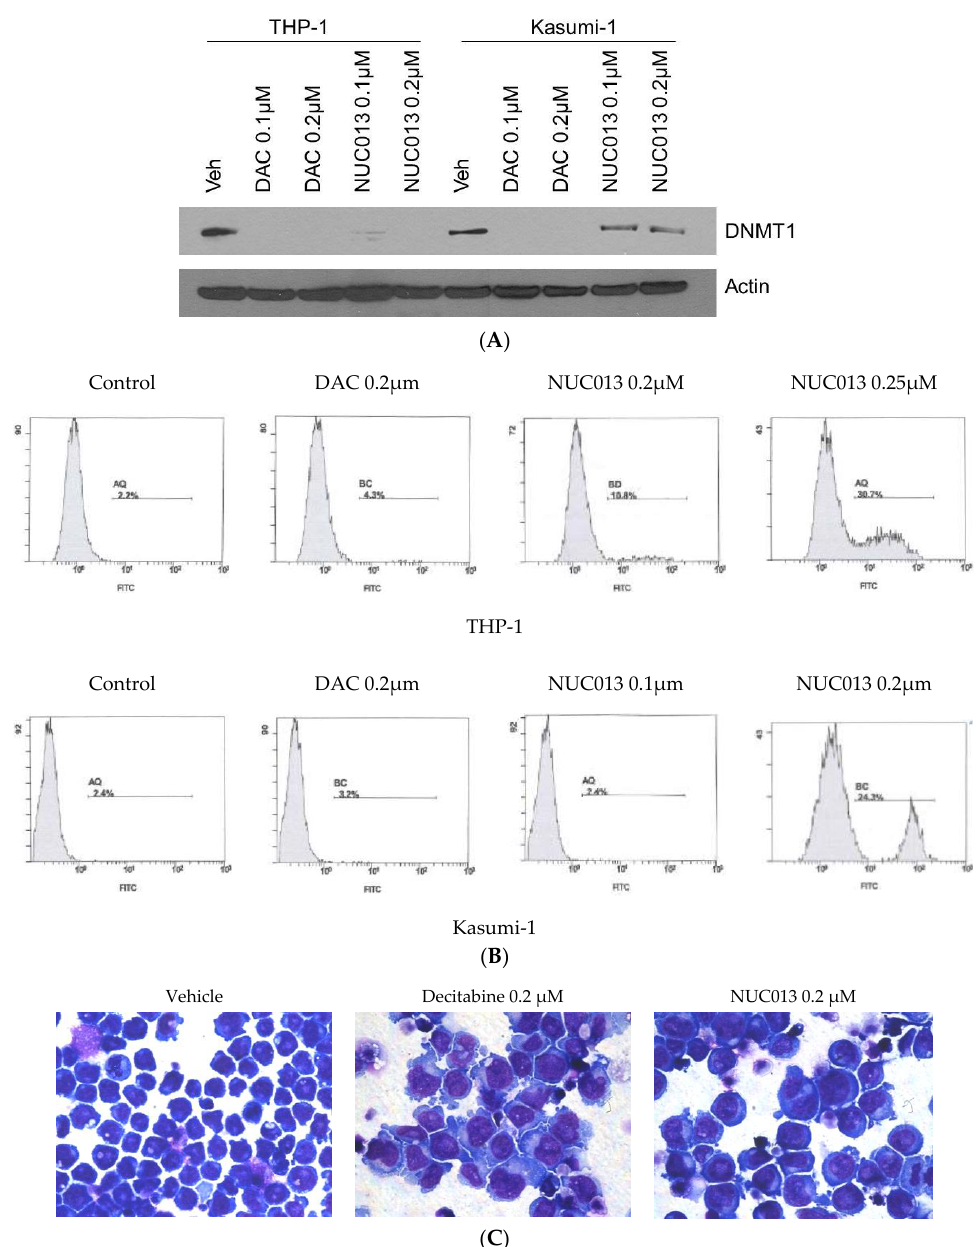
Figure 2. ( A ) Western blot comparing vehicle (veh) to decitabine (DAC) and NUC013 6 days after exposure to 0.1 µM and 0.2 µM of nucleoside and probing with DNA methyl transferase (DNMT1) antibody in human leukemia cells lines THP-1 and Kasumi-1; ( B ) Comparison of induction of apoptosis in THP-1 or Kasumi-1 cells by vehicle control, decitabine (0.2 µM) or NUC013 (concentrations as indicated in figure). Cells were co-stained with Annexin-V and PI on day 2 and analyzed by flow cytometry. Only Annexin-V data are presented because there were no changes in propidium iodide (PI) staining over the time period; ( C ) Photomicrographs of THP-1 cells treated with vehicle, decitabine or NUC013 on day 6 following drug exposure and stained with Giemsa (×630).